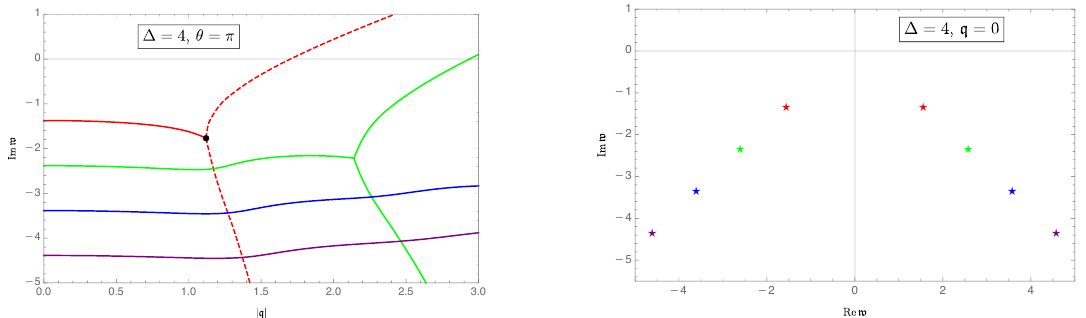
Figure 10 . Left panel: dispersion relations of the lowest four QNMs at ∆ = 4 and q 2 = | q 2 | e iθ with θ = π . Right panel: spectrum of the lowest four QNMs at ∆ = 4 and q = 0 . The black dot in the left panel is identical to the black dot located on the negative part of the Re − q 2 axis in figure 4.